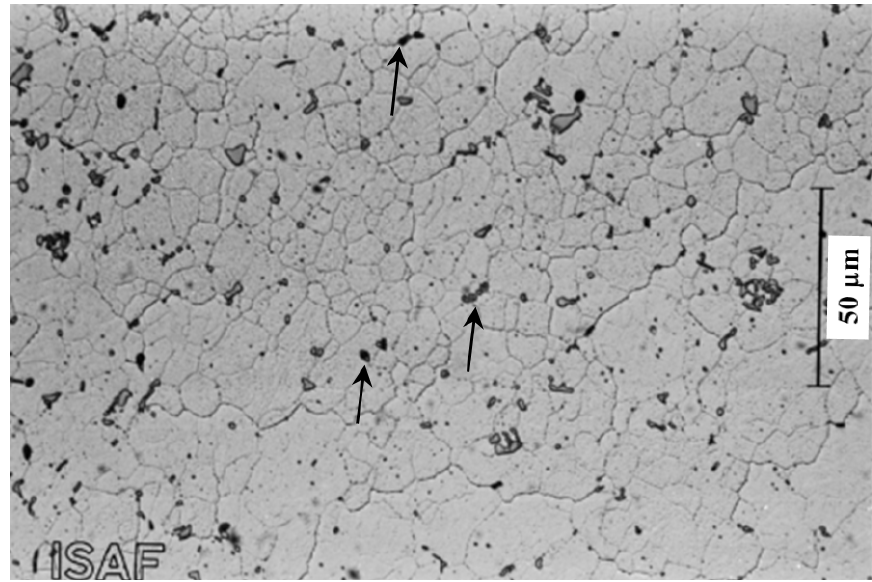
Figure 1. Photo of the microstructure of the AlMgSi1 alloy in a finely polished state. Mg2 Si precipitates are pointed out by arrows. (ISAF is Institut für Schweißtechnik und Trennende Fertigungsverfahren, Germany).